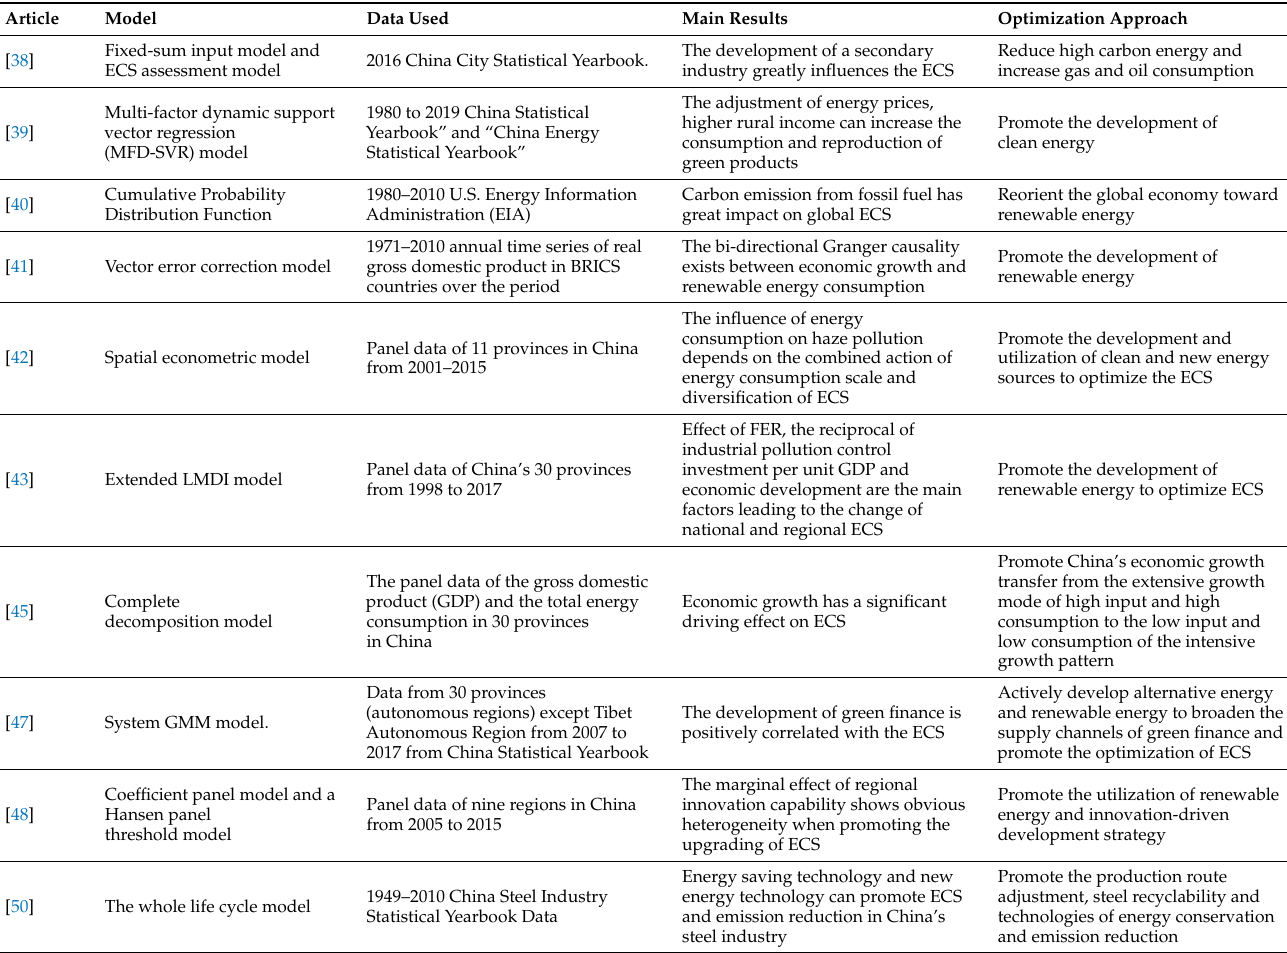
Table 1. The results of empirical studies on